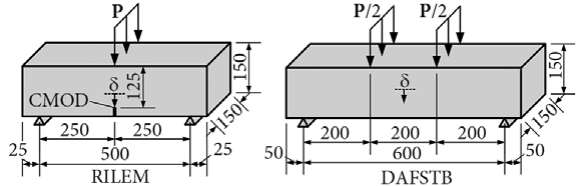
Fig. 1. Specimens and loading schemes of the Rilem and the